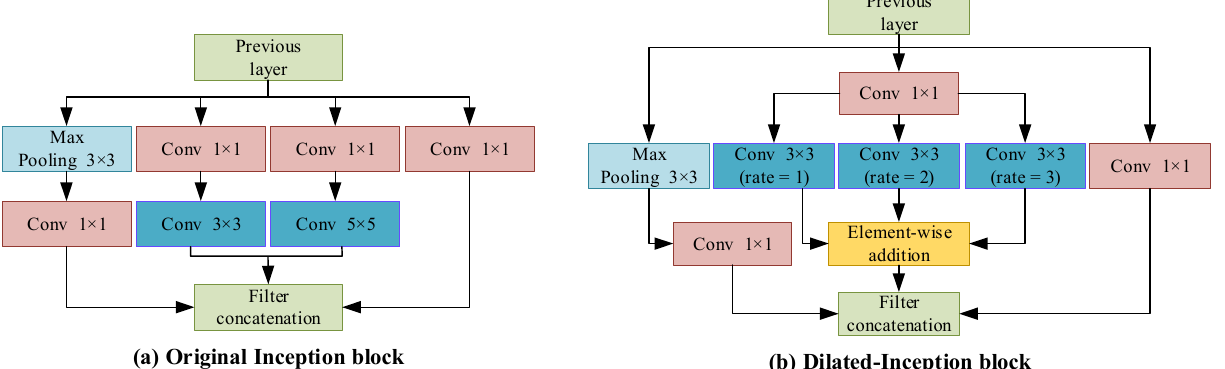
Figure 6. The inception module with its variations.